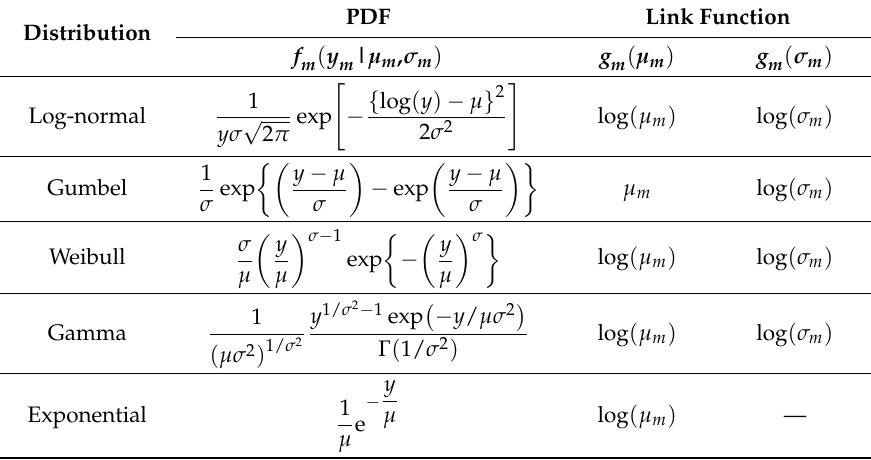
Table 2. Definition and properties of the marginal distributions used in the